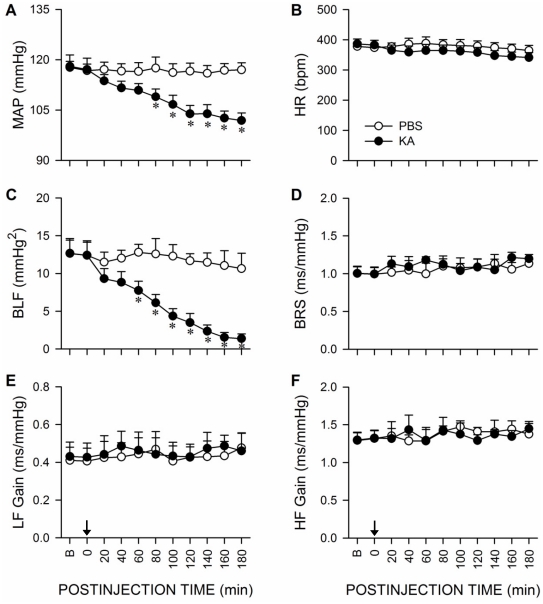
Reduced baroreflex-mediated sympathetic vasomotor tone during experimental TLSE.Temporal changes in mean arterial pressure (MAP) (A), heart rate (HR;) (B), power density of the low-frequency (BLF) component of systolic blood pressure (SBP) spectrum (C), baroreflex sensitivity (BRS) (D), and gain of transfer function between pulse interval and SBP spectra at the low-frequency (LF) (E) or high-frequency (HF) (F) bands on microinjection of KA (0.5 nmol) or PBS into the left hippocampal CA3 subfield (at arrow). Values are mean ± SEM from 5–7 animals per experimental group. *P<0.05 versus PBS group at corresponding time-points in the post hoc Scheffé multiple-range test. B = preinjection baseline.